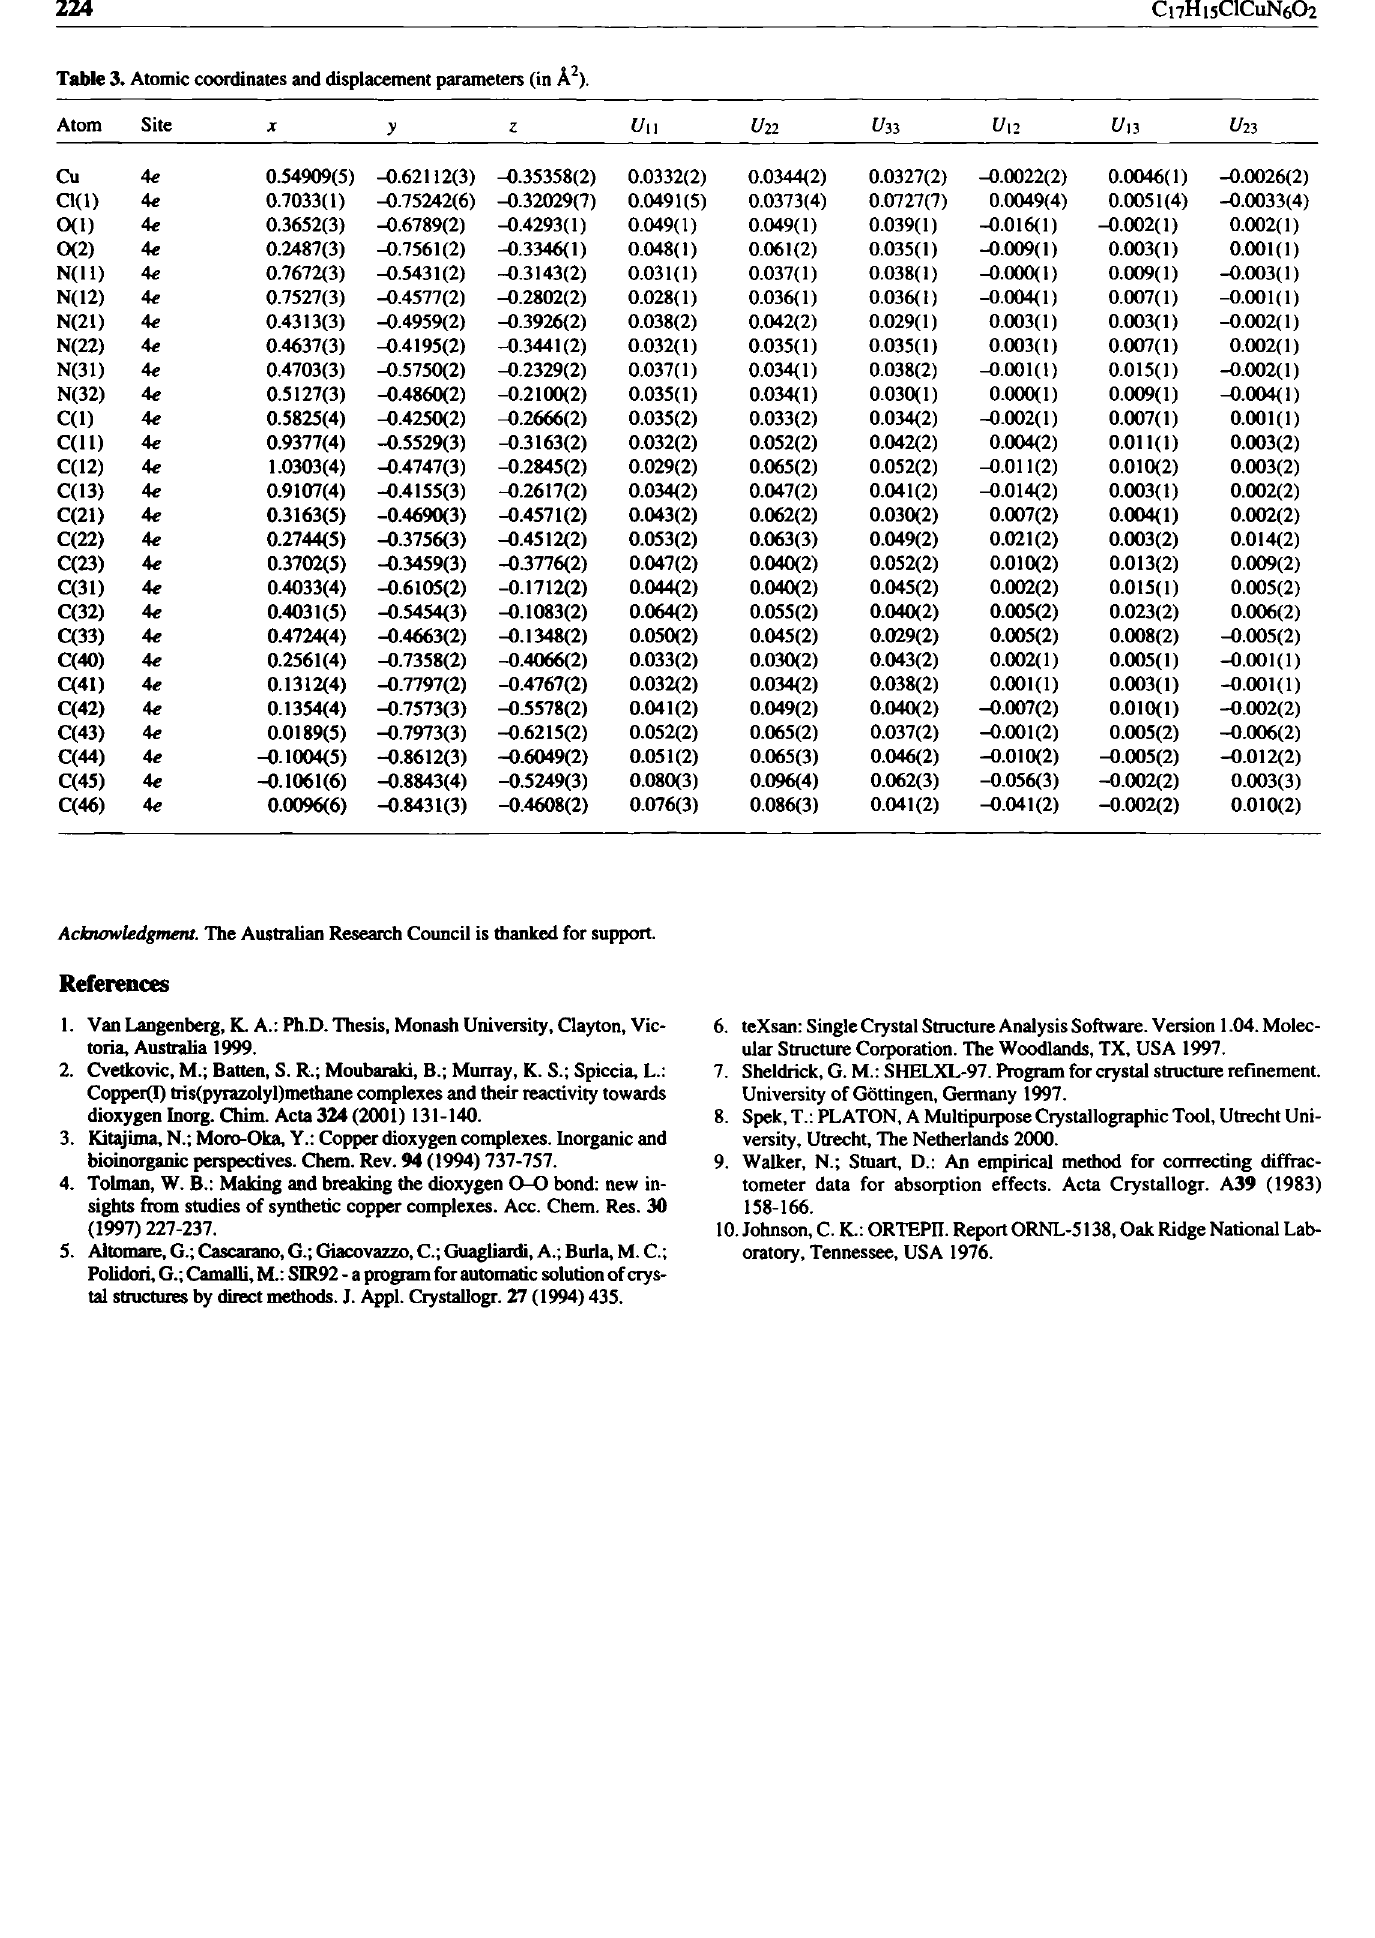
Table 3. Atomic coordinates and displacement parameters (in Â 2